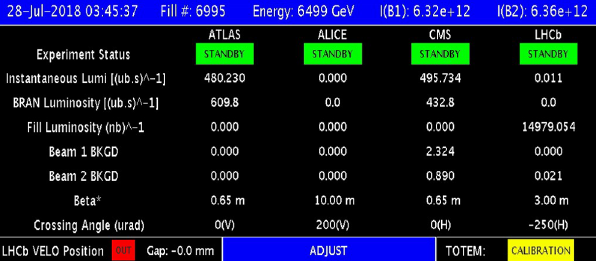
FIG. 14. 2018 flat ATS MD: First collision of bunch trains with flat optics ( 12 þ 48 colliding bunches with h N p i¼ 1 . 03 × 10 11 p = b). The luminosity was approaching 5 × 10 32 cm − 2 s − 1 in ATLAS and CMS (corresponding to 10 35 cm − 2 s − 1 for 2748 colliding bunches and 2 . 2 × 10 11 p = b). This picture, taken during the MD to keep record of the first collisions of bunch trains with flat optics at the LHC, is a snapshot of the so-called “ LHC page 1 ” [27], where the main beam, optics and luminosity related parameters are dynamically published during nominal